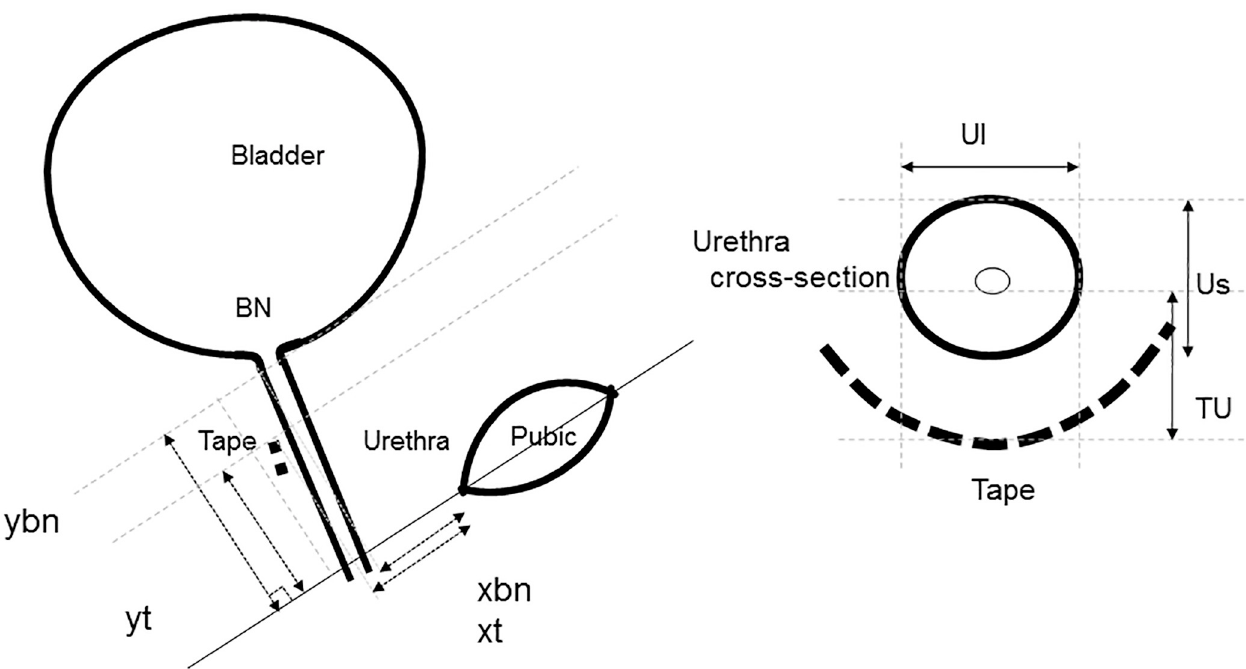
Fig 2. Graphical representation of the ultrasound parameters exploring the sling (xt, yt), BN position (xbn, ybn) and tape tension (TU, Ul, Us); BN Bladder Neck, distances between the mid position of the sling and center of urethral core (TU), the shortest (Us) and, longest (Ul) diameters, (xt, yt) x and y axis exploring the sling and (xbn, ybn) x and y axis exploring the bladder neck position.